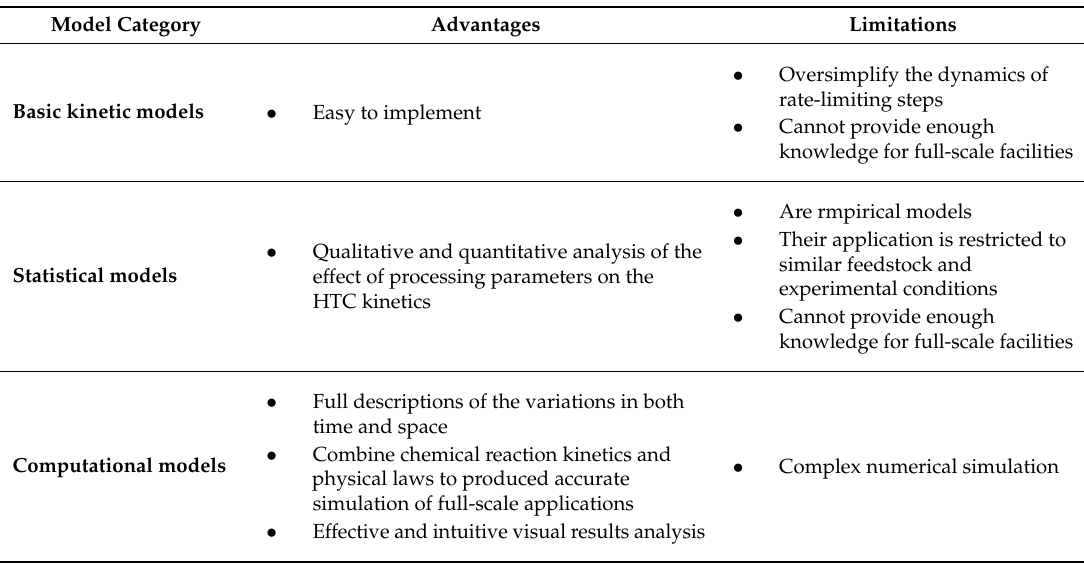
Table 1. Advantages and limitations of hydrothermal carbonization (HTC) kinetics models. Model